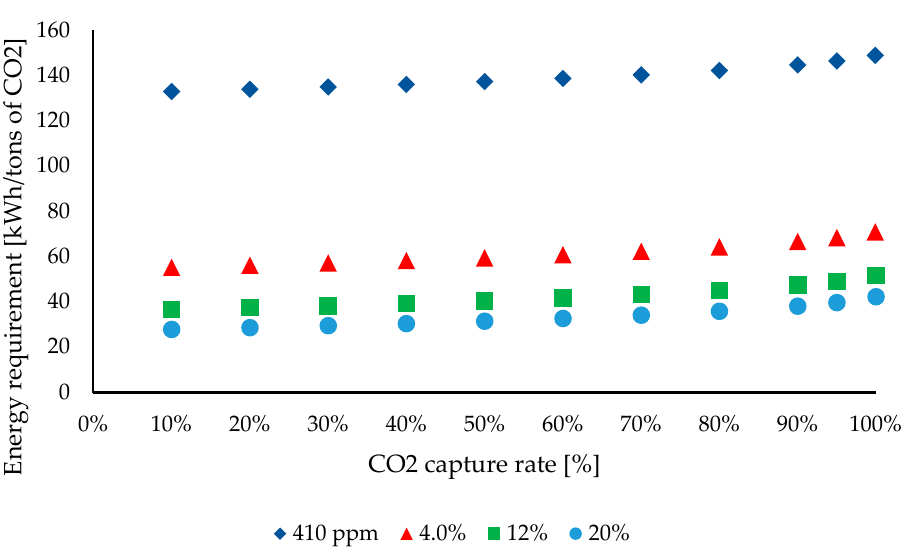
Figure 2. Minimum energy requirement for CO 2 capture depending on the capture rate and inlet concentration of CO 2 at 50 ◦ C. W = − RT (cid:4676)(cid:1864)(cid:1866) (cid:4674)